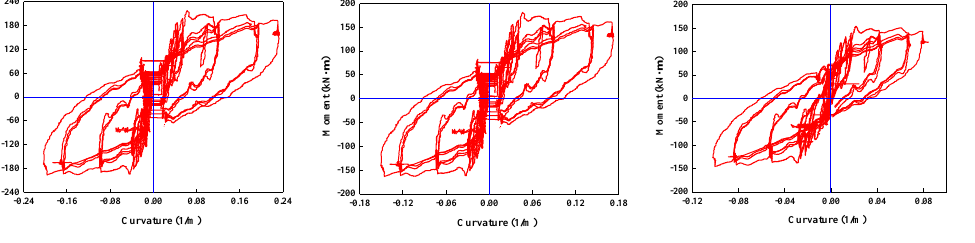
( c ) PPECC-3: 15 cm (left); 30 cm (middle); 60 cm (right)